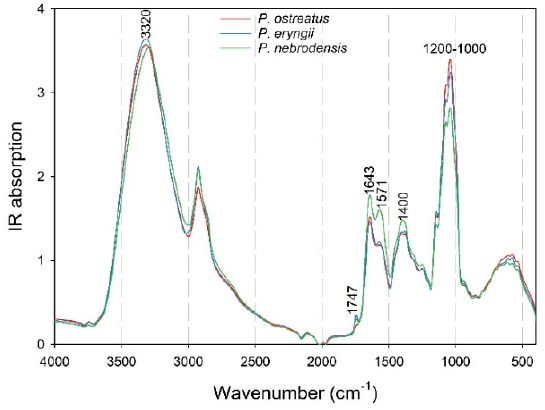
Figure 3. Recorded ATR-FTIR spectra for the Pleurotus ostreatus , P. eryngii and P. nebrodensis mushrooms cultivated on wheat straw (WS).